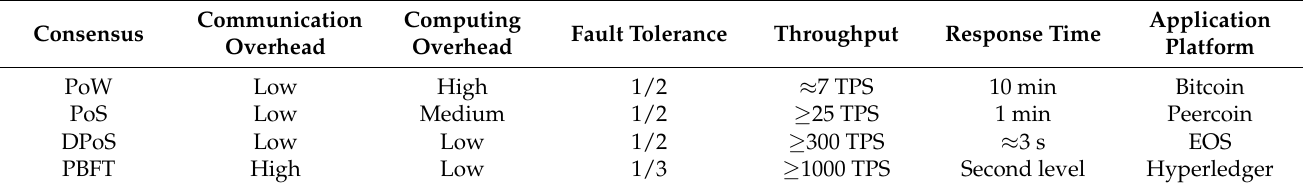
Table 1. Consensus algorithm complexity